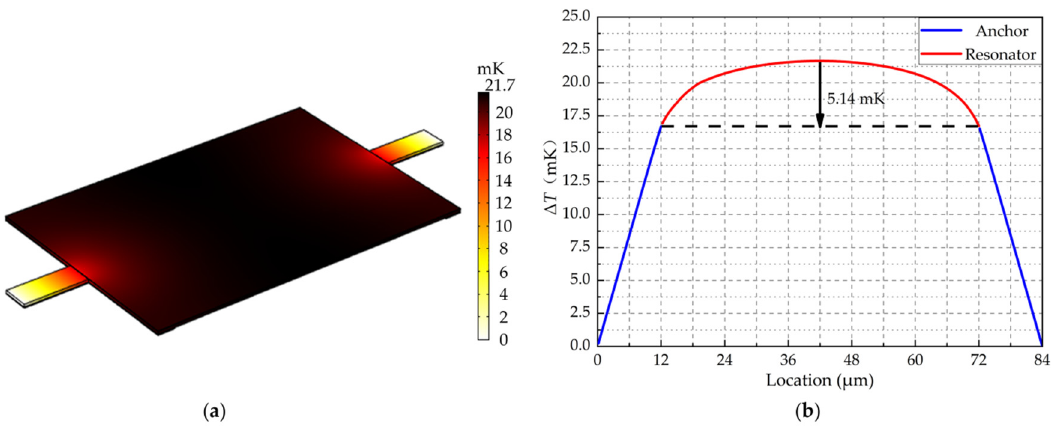
Figure 13. Calculated temperature distribution of the device at the status of thermal equilibrium over: ( a ) The whole structure; ( b ) along the length. Table 1. Calculated τ , Δ T , and R th for the detector with different anchor dimensions. w Anc ( µ